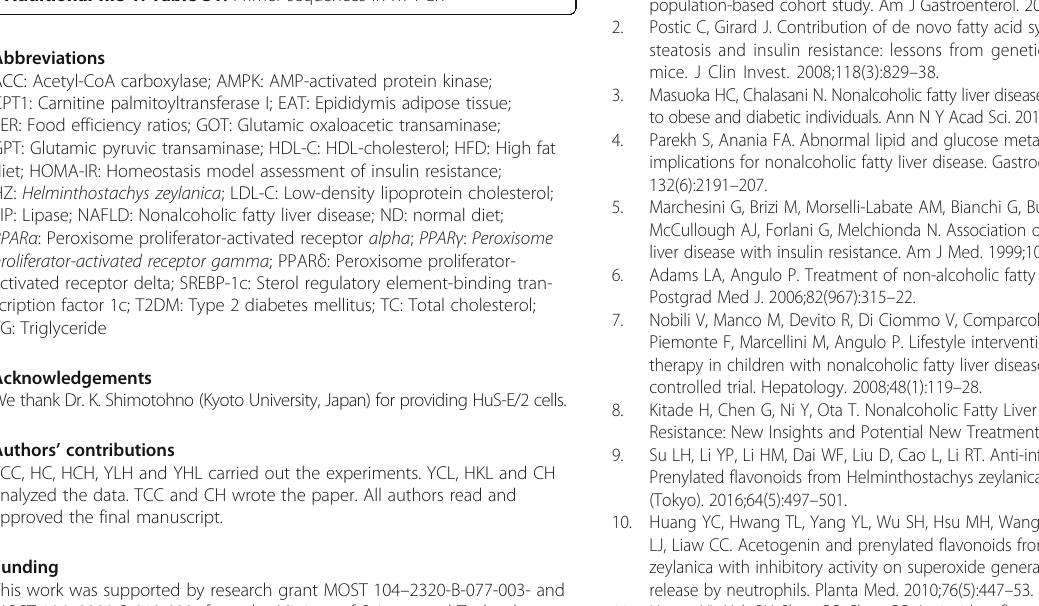
Additional file 1: Table S1. Primer sequences in